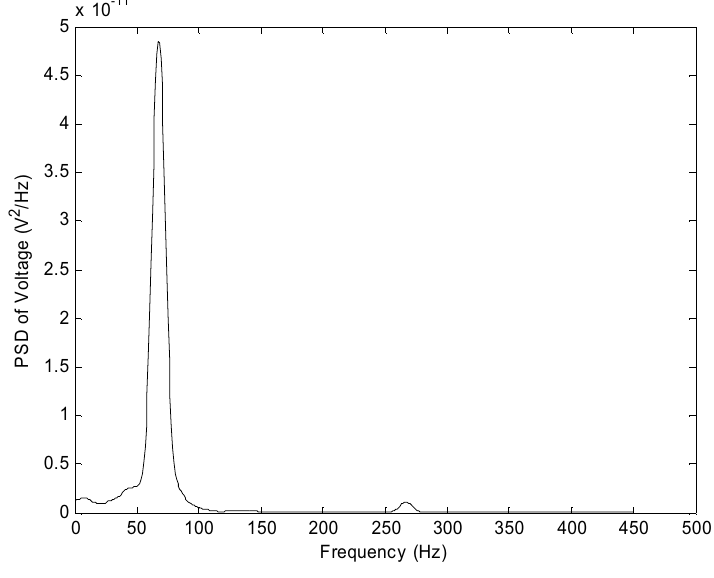
Fig. 10. Frequency spectrum of the PZT sensor voltage of Fig. 9.